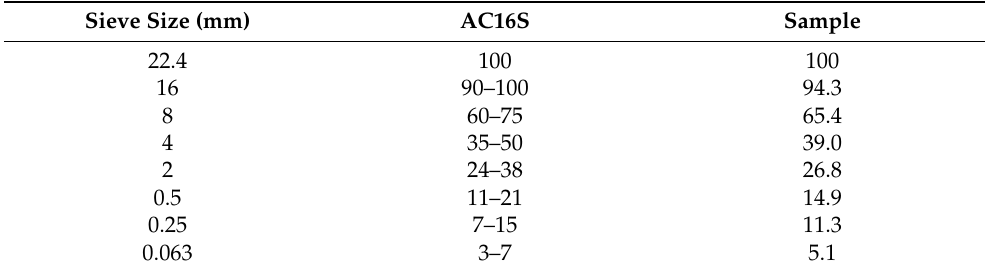
Table 1. Particle size distribution of AC16S and mixtures